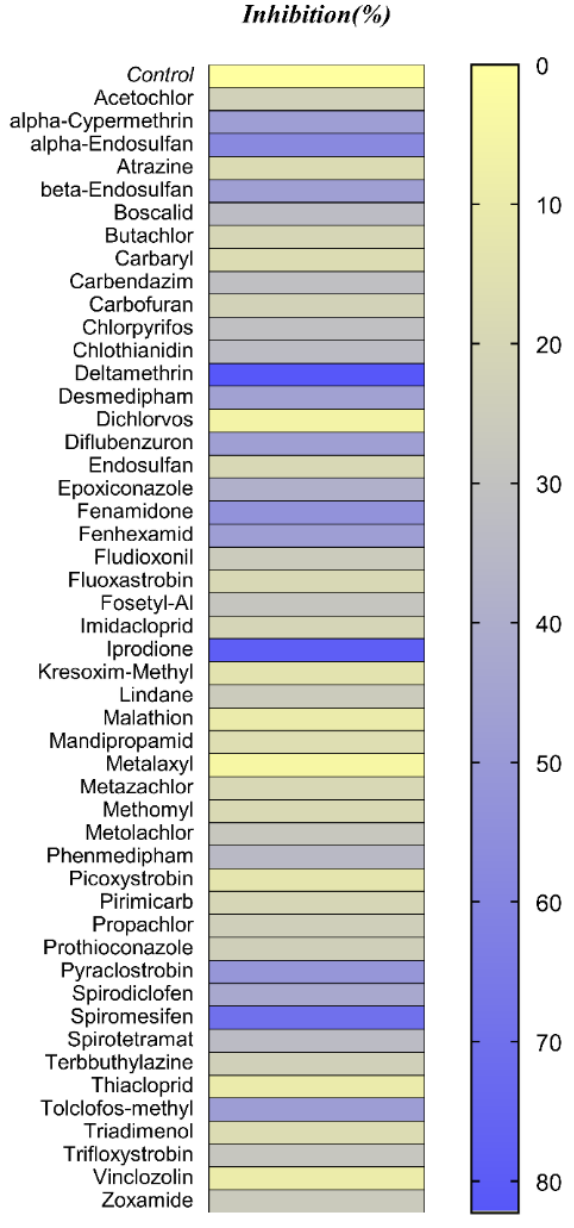
Figure 2. Screening of the inhibitory potency of pesticides (25 μM) against Mm GSTP1-1. The enzyme was assayed in all measurements using the CDNB-GSH assay system. The colour scale represents the mean values of three inhibition assays (%) for each pesticide against the tested enzyme with a variation of less than 5% in all cases.